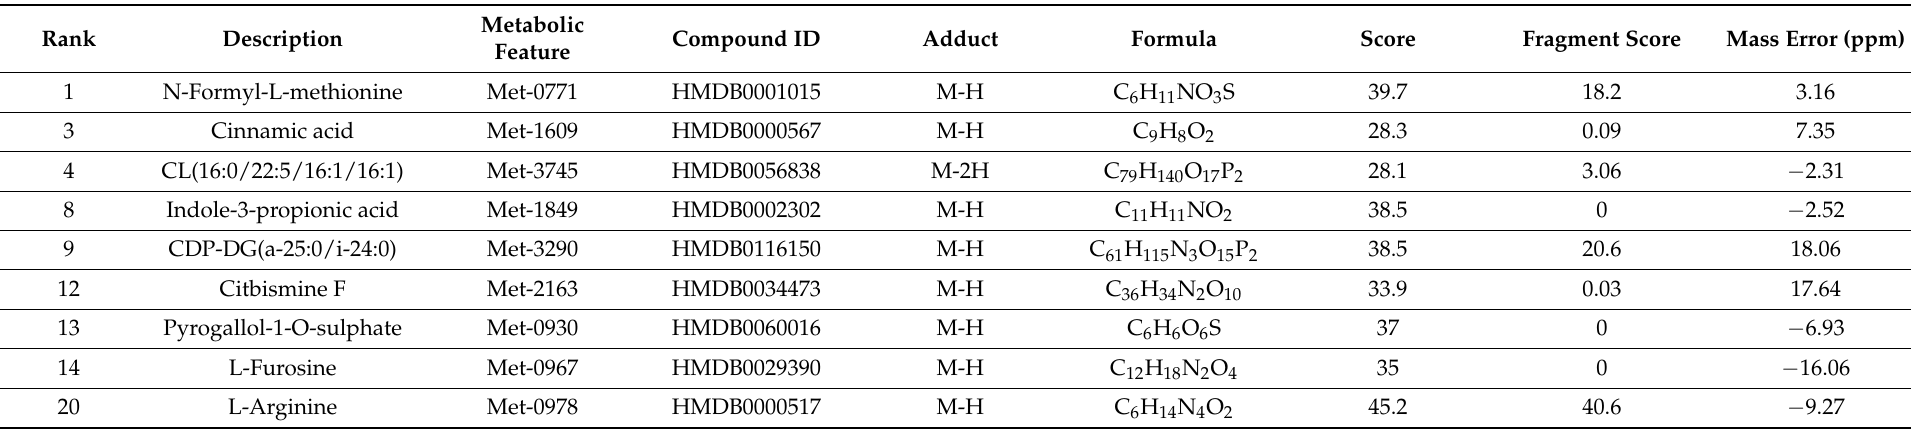
Table 2. List of the nine ML-selected MCI-differentiating features with their identified metabolite